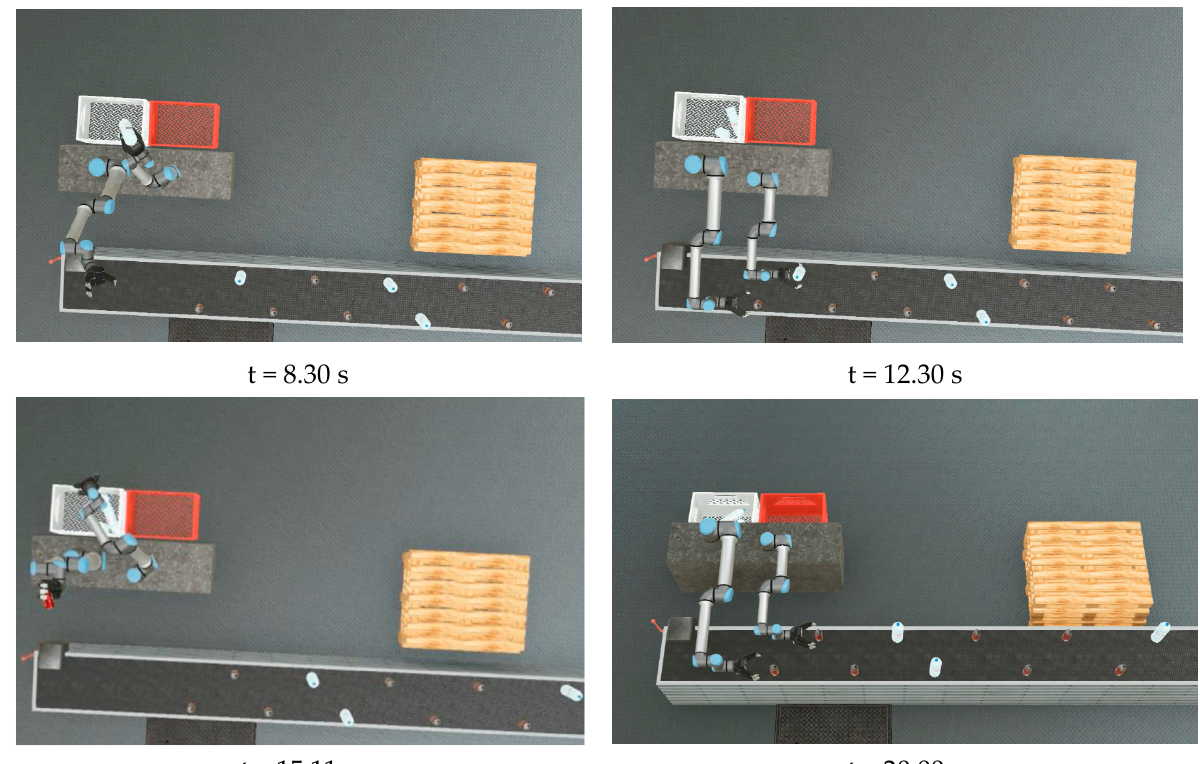
Figure 16. Snapshots from the simulations.